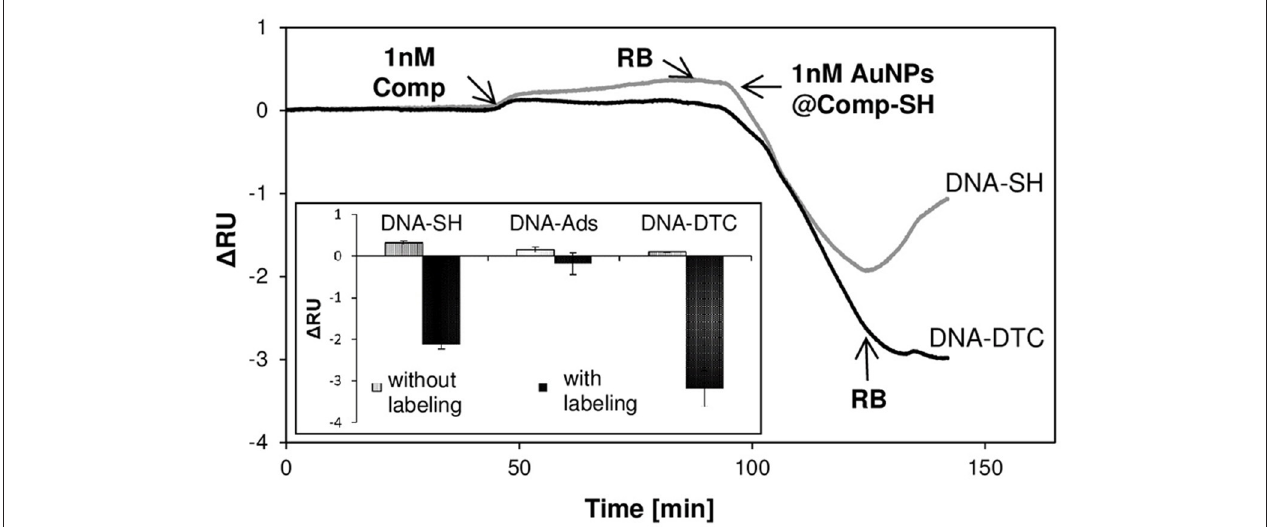
FIGURE 6 | The performance of SPR response enhancement by introduction of AuNPs labels in competitive assay . Exemplary SPRi sensograms illustrating the real-time responses after subsequent injection of Comp sequence and AuNPs@ Comp-SH label. Inset shows the values of total RU shifts calculated before (gray bars) and after labeling in competitive mode (black bars). Rand sequence (1nM) and AuNPs@ Comp-SH label (1nM) were simultaneously injected into the reference cell, respectively.